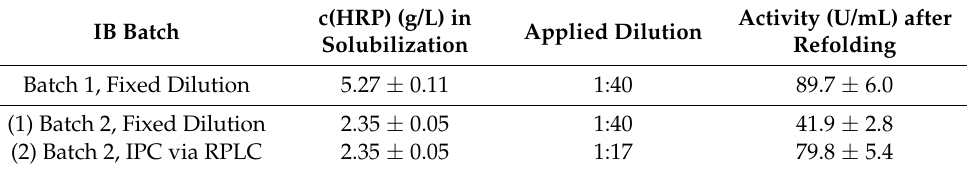
in the refolding buffer as well as the activity after refolding are given for the two different IB batches. Two different dilutions were done for Batch 2: (1) solubilizate was diluted with a fixed dilution (1:40) and (2) dilution was adapted to achieve the same HRP concentration as for Batch 1